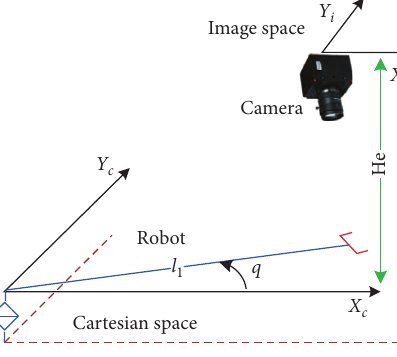
Figure 9: The coordinate relation of Cartesian space and image space.